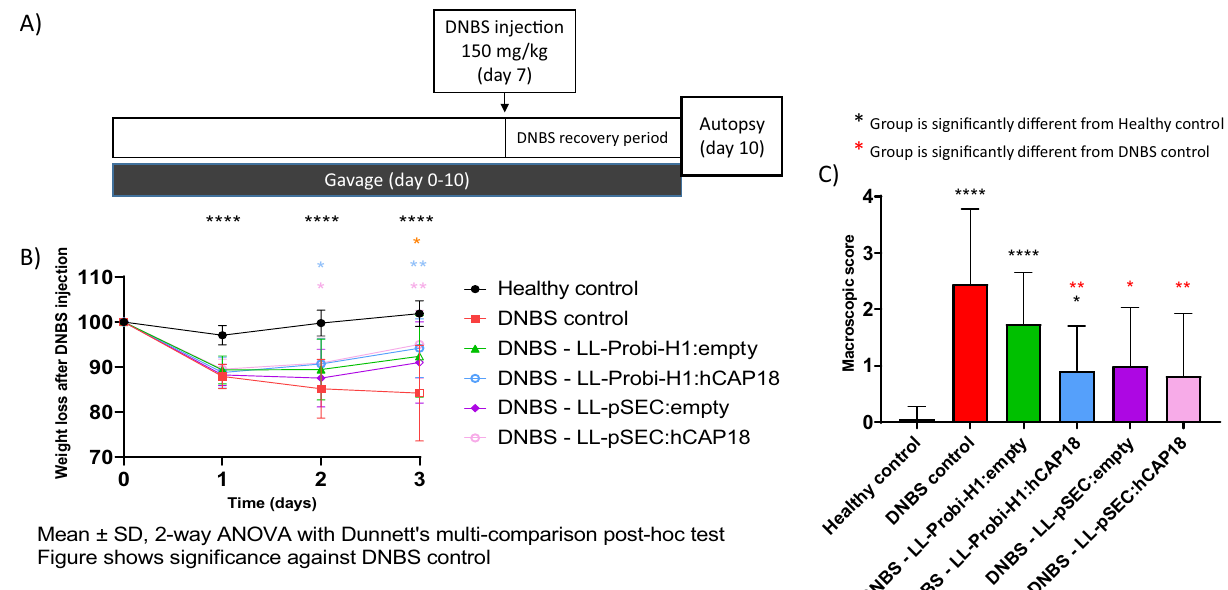
Figure 1. Effect of DNBS injection on weight loss and macroscopic score on experimental groups receiving recombinant L. lactis or not. ( A ) Experimental protocol for the DNBS-induced model of colitis in mice. Effects of LL-Probi-H1-empty, LL-Probi-H1-hCAP18, LL-pSEC:empty and LL-pSEC:hCAP18 on recovery from DNBS with respect to ( B ) body weight and ( C ) macroscopic score. Data represent mean ± SD. *P < 0.05, **P < 0.01, ***P < 0.001, ****P < 0.0001, n = 24 mice per group for LL-Probi-H1:empty and LL-Probi-H1:hCAP18, n = 16 for LL-pSEC:empty and LL-pSEC:hCAP18, n = 20 mice for healthy control.